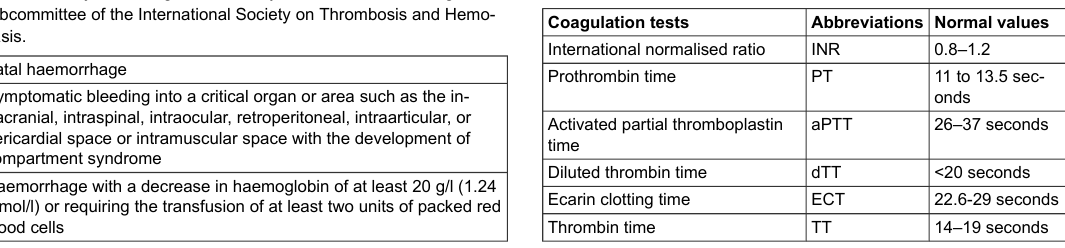
Table 2: Coagulation